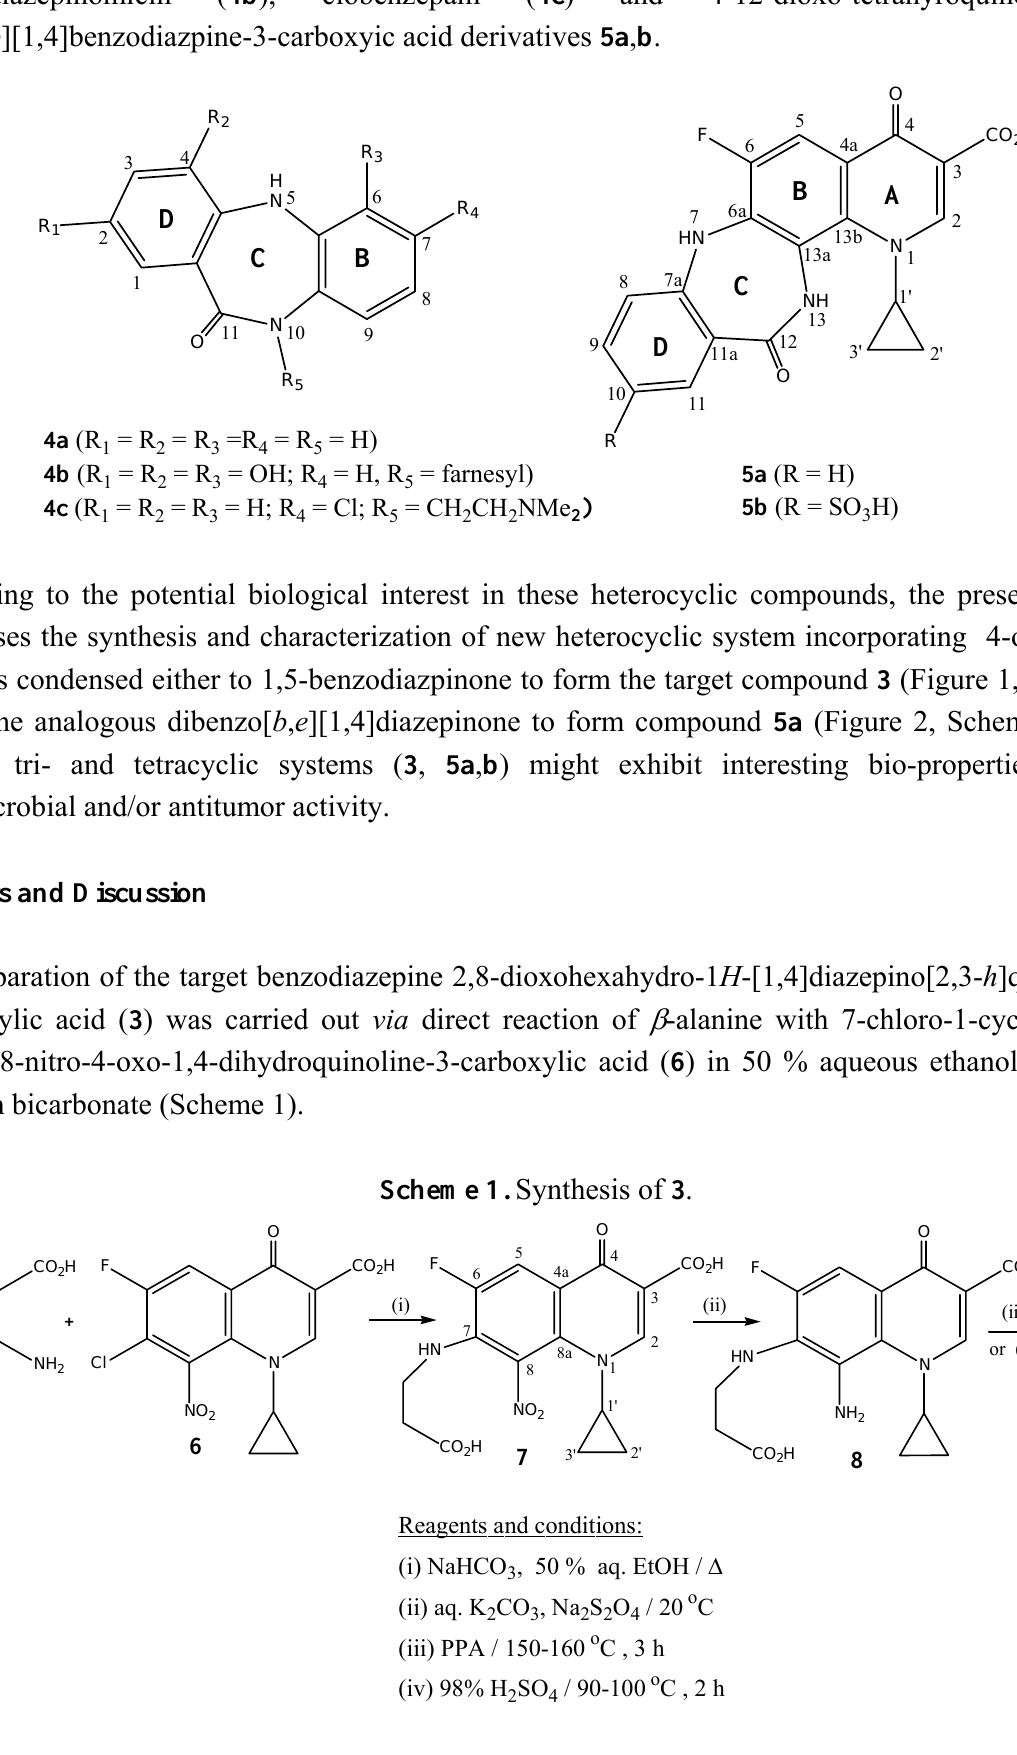
Figure 2. Structures of 5,10-dihydro-11 H -dibenzo[ b , e ][1,4]diazepine-11-one ( 4a ), diazepinomicin ( 4b ), clobenzepam ( 4c ) and